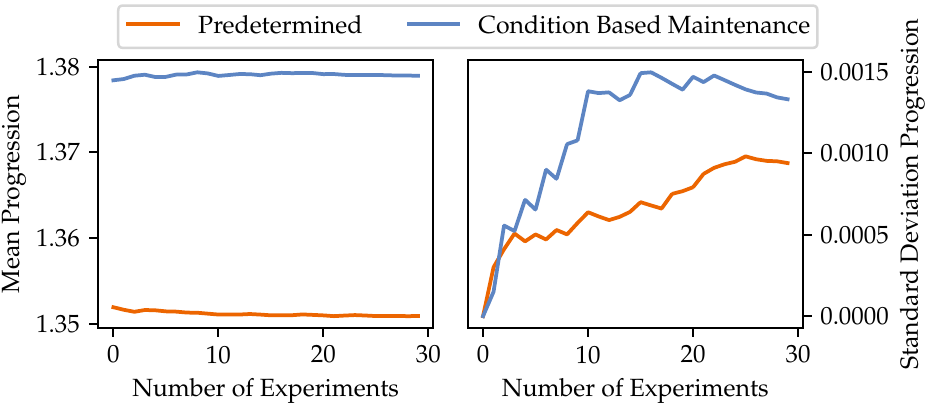
Figure 11. Progression of mean and standard deviation over the number of simulation runs for M usage